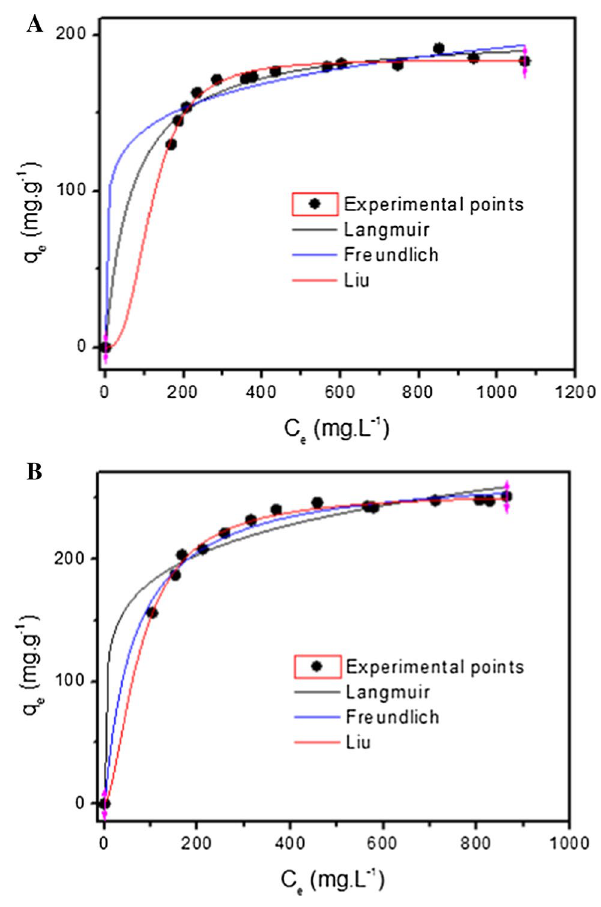
Fig. 6 Isotherm curves of adsorption of PR-5B onto a CAC and b